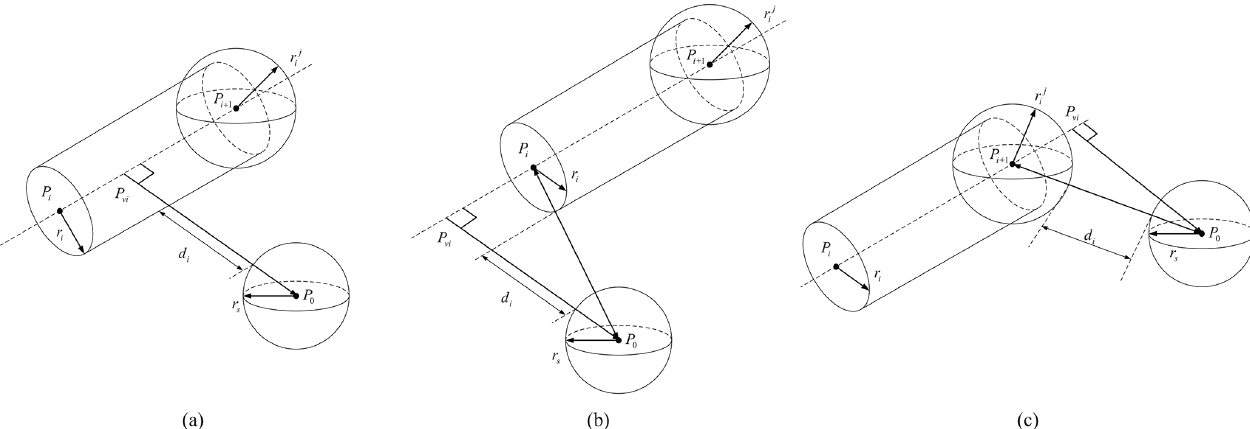
Figure 3. The space geometry relations between manipulator’s links and obstacle. (a) Class I. (b) Class II. (c) Class III.